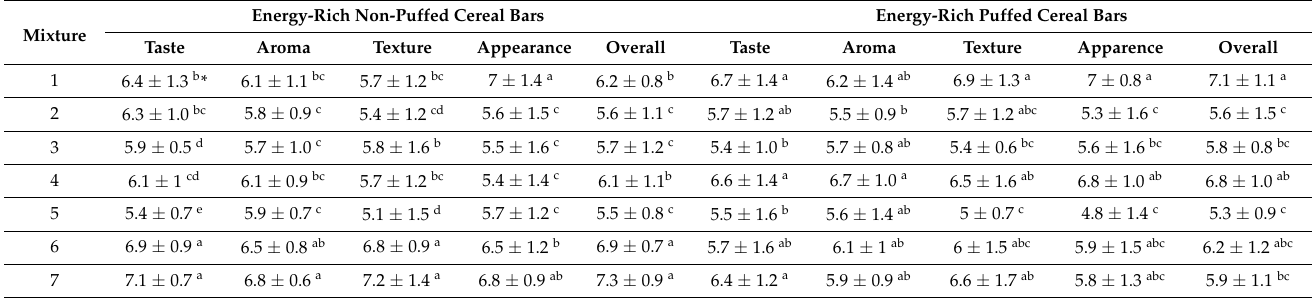
Table 4. Sensory properties of energy-rich cereal bars with puffed and non-puffed cereals based on mixture design.